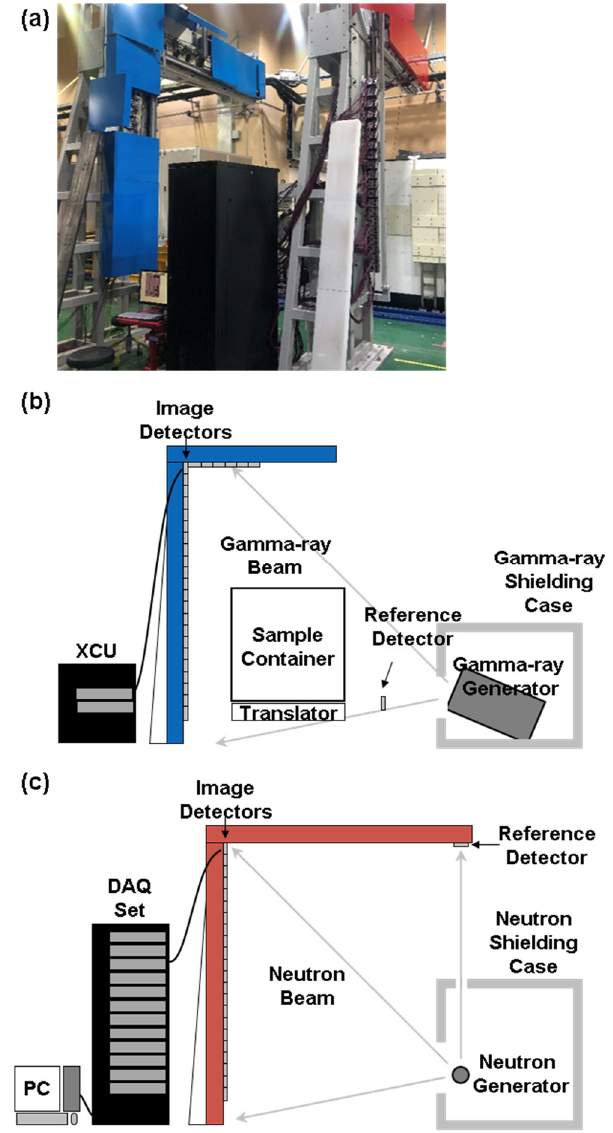
Figure 1. Air cargo inspection system: ( a ) image of the system, ( b ) diagram of the gamma-ray imaging system, and ( c ) diagram of the neutron imaging system.